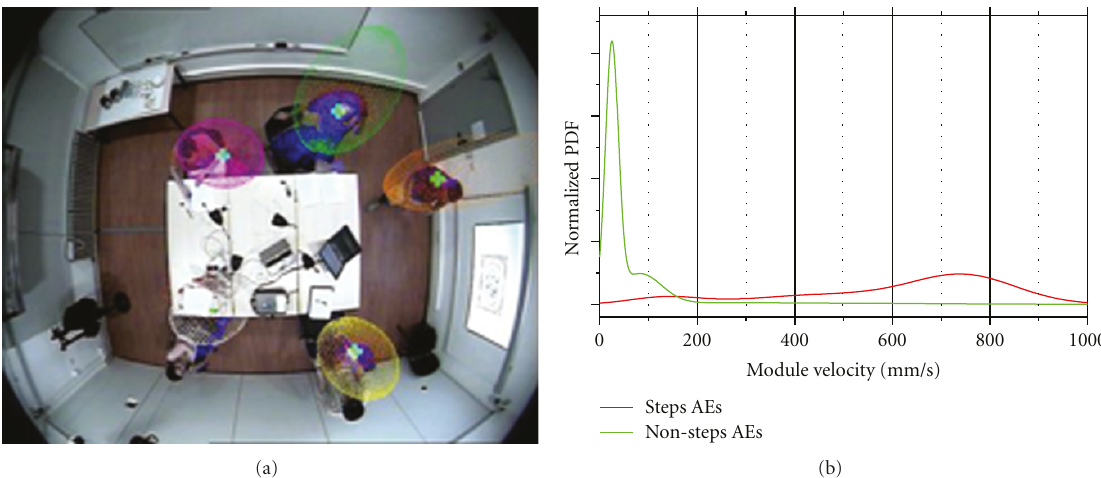
Figure 3: Person tracking. In (a), the output of the employed algorithm in a scenario involving multiple targets. In (b), the likelihood functions of the velocity feature corresponding to “Steps” and “Nonsteps” AEs.